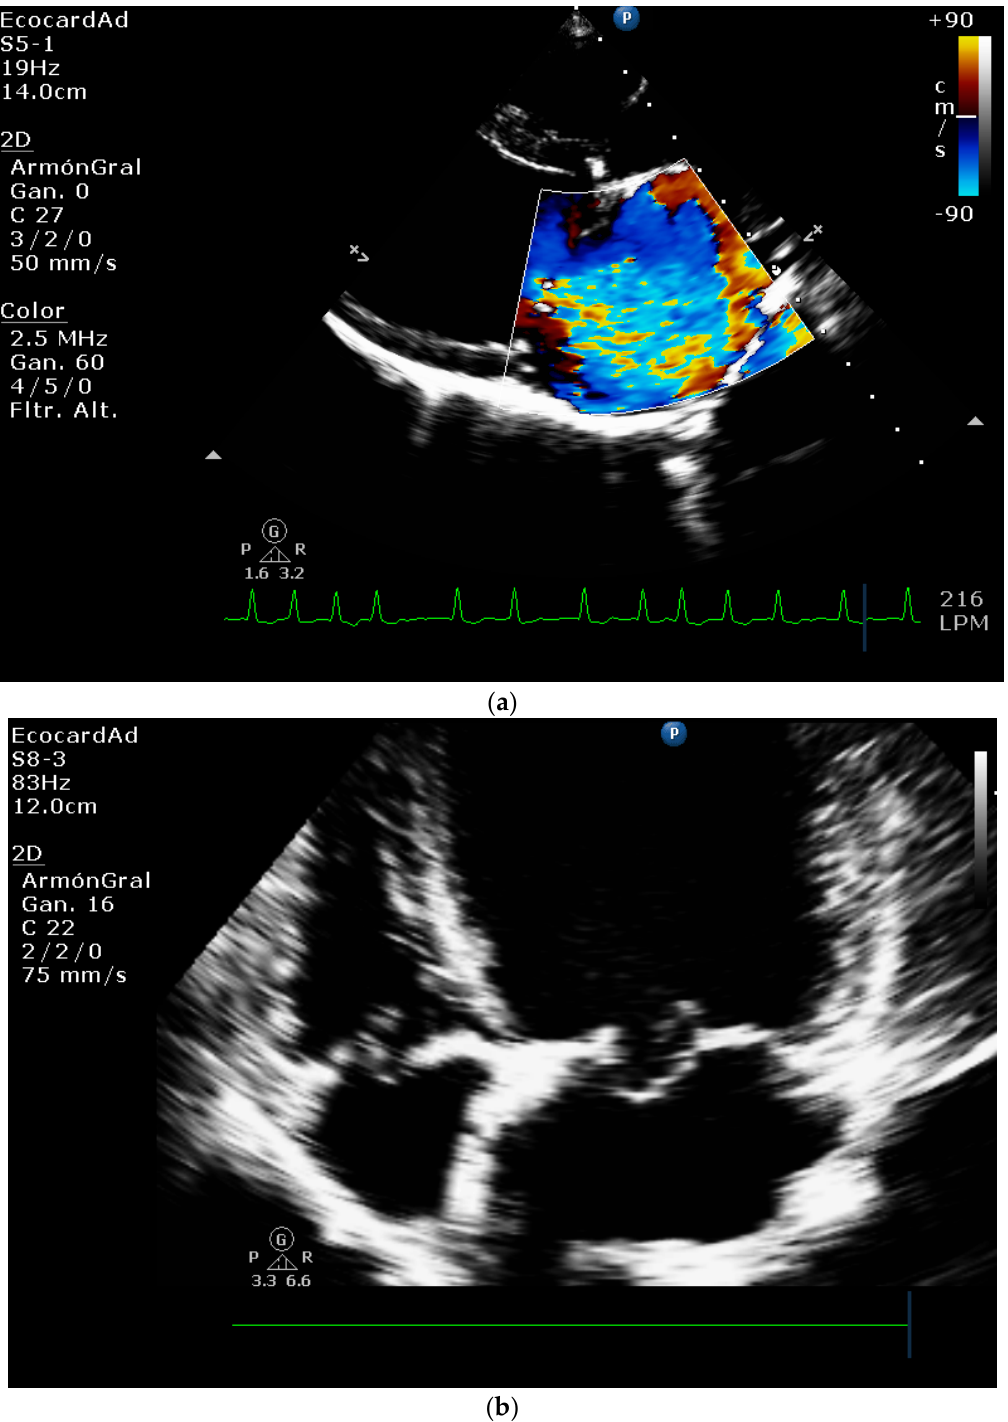
Figure 5. ( a ) Mitral insufficiency and ( b ) Septal leaflet prolapse associated with Myxomatous degeneration in a canine patient.